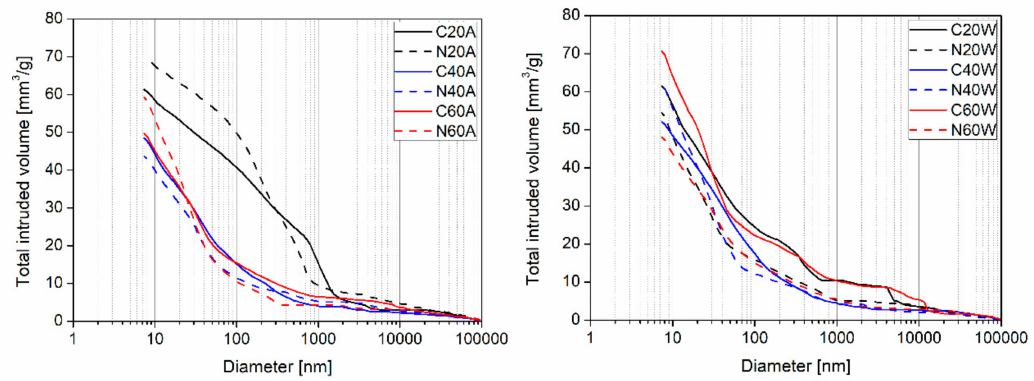
Figure 10. Cumulative intruded pore volume versus pore diameter of hot air-cured ( left ) and hot water-cured specimens ( right ). Table 2. Porosities, average pore diameter, and median diameter of the cement mortars after 180 days of curing.